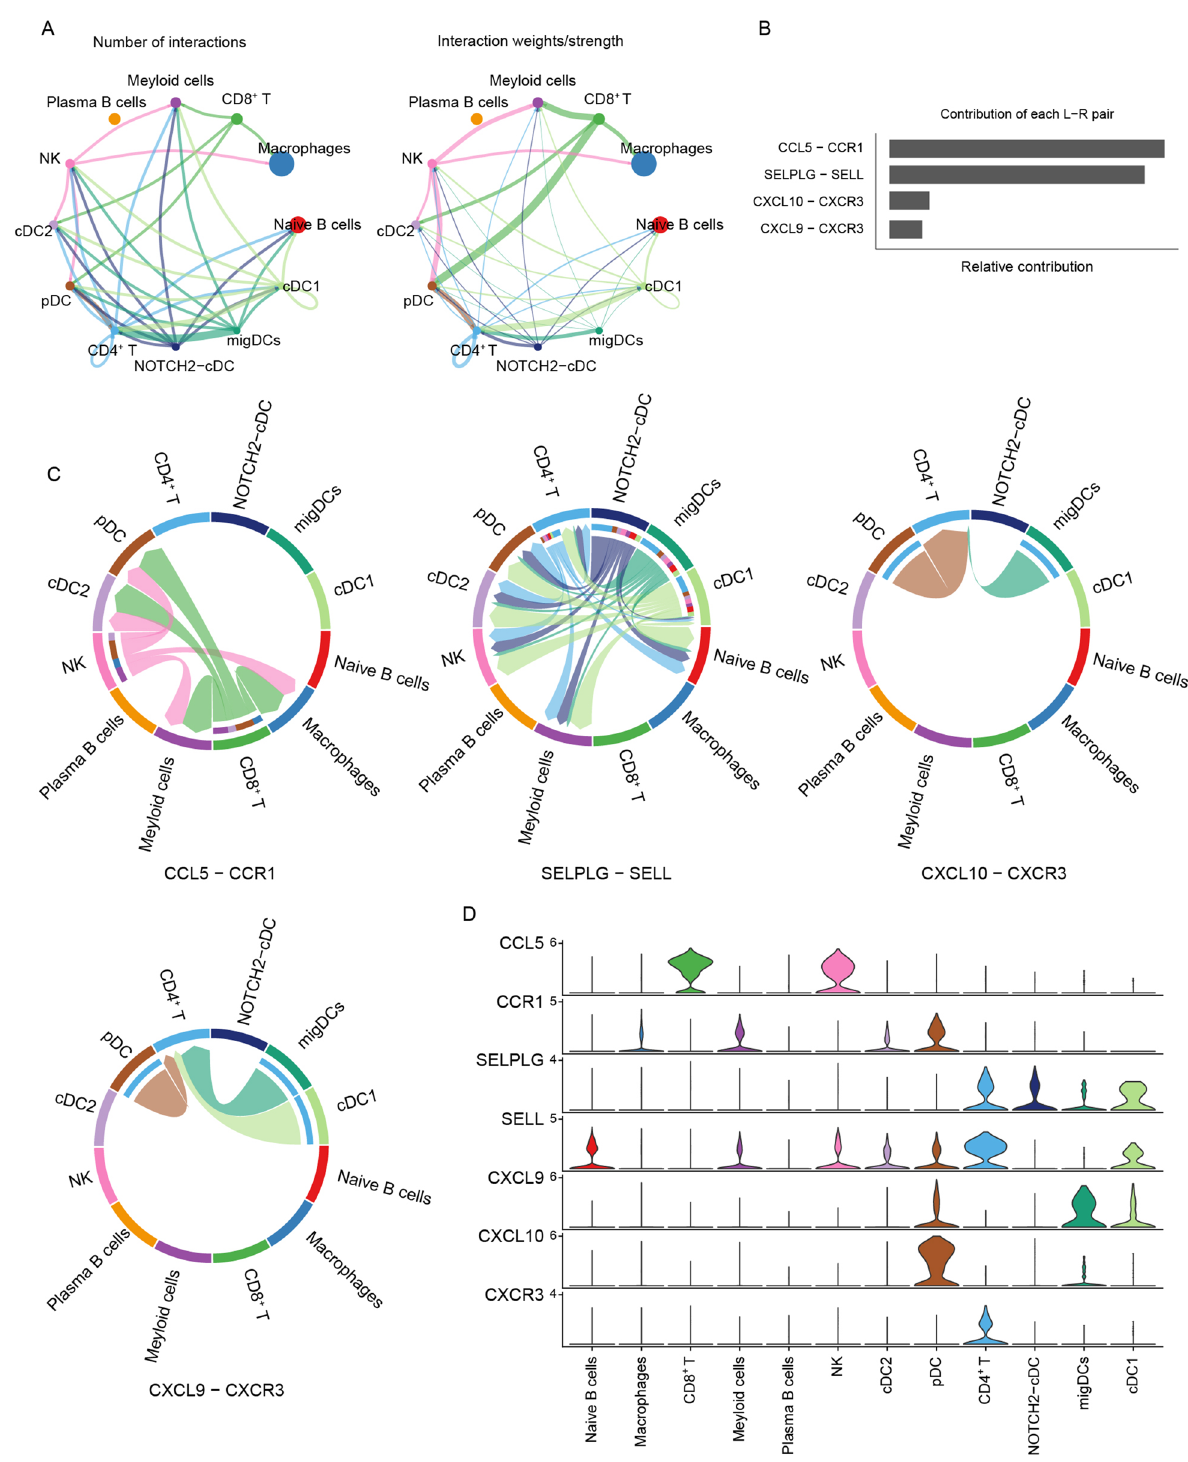
Figure 8. Cell communication network diagram. ( A ) The number of ligand receptor interactions detected between different cell types. ( B ) Ligand receptor contribution to the overall signaling pathway. The CCL5/CCR1 ligand receptor pair contributed the most, followed by the SELPLG/SELL ligand receptor pair. ( C ) Receptor ligand pair interactions between immune cells. ( D ) The distribution and expression level of signal genes involved in the three signal pathway